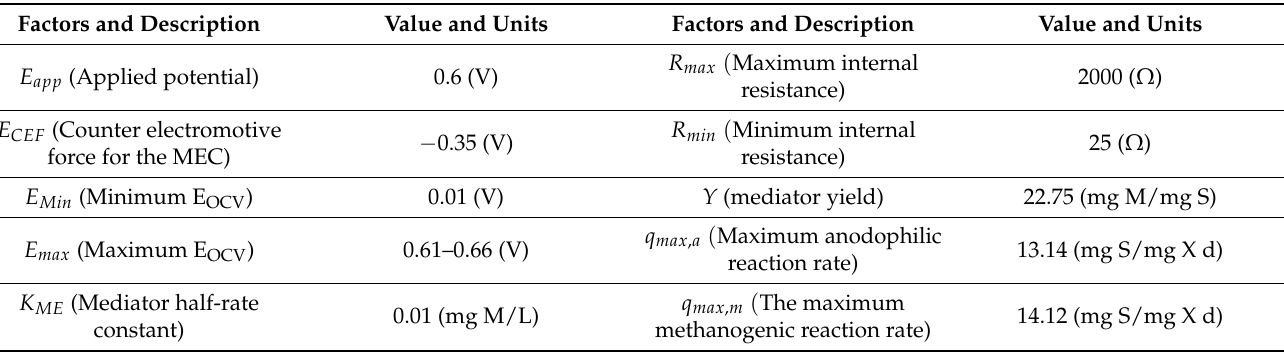
Table 1. The operation factors for the thermodynamic modelling of the decentralized wastewater